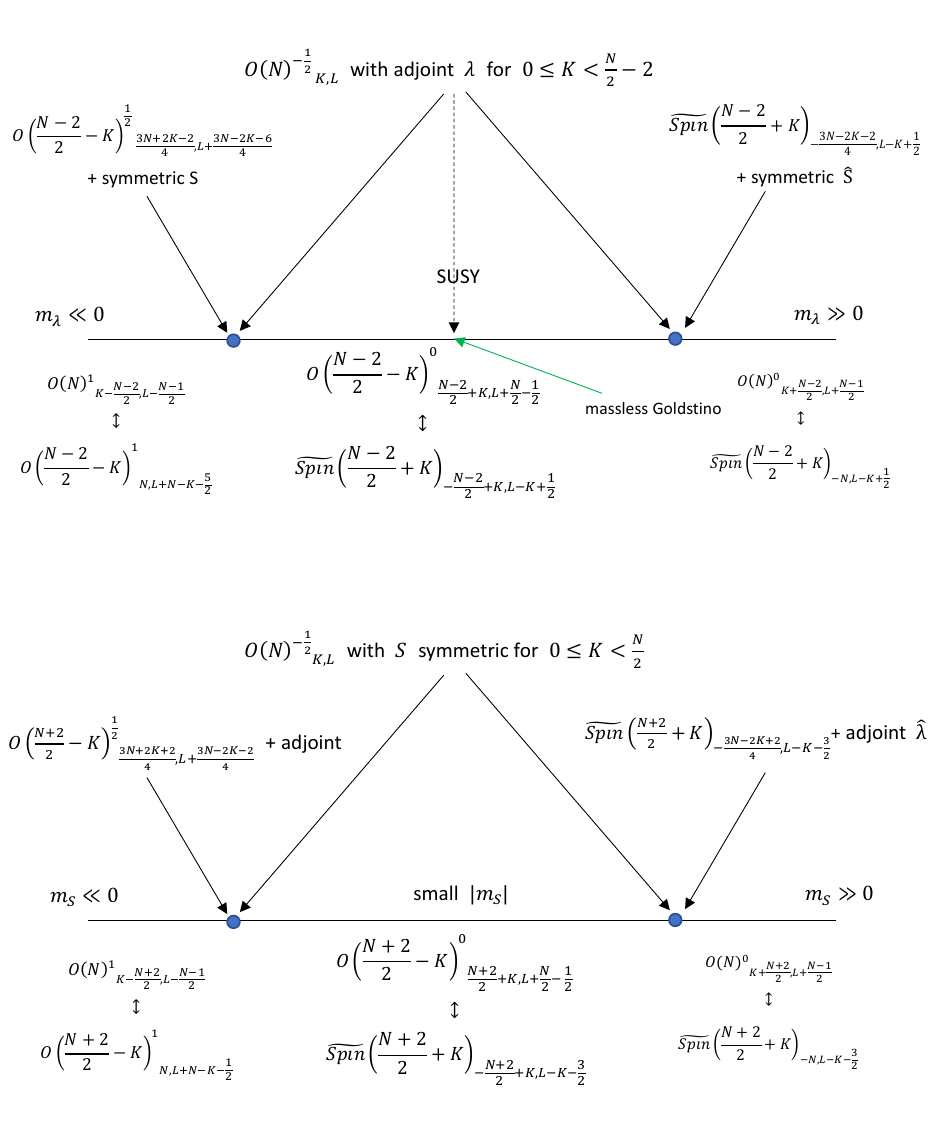
Figure 7: The phase diagrams of O ( N ) − infrared TQFTs, together with relevant level-rank duals are shown along the bottom. The blue dots indicate the transitions from the semiclassical phase to the quantum phase. This proceeds through a tensor transition described by a dual theory, which covers part of the phase diagram. Across these tensor transitions O ( L ) 0 and O ( L ) 1 are exchanged. At a special value of the mass in the quantum phase of the adjoint theory, a massless goldstino appears. The notation